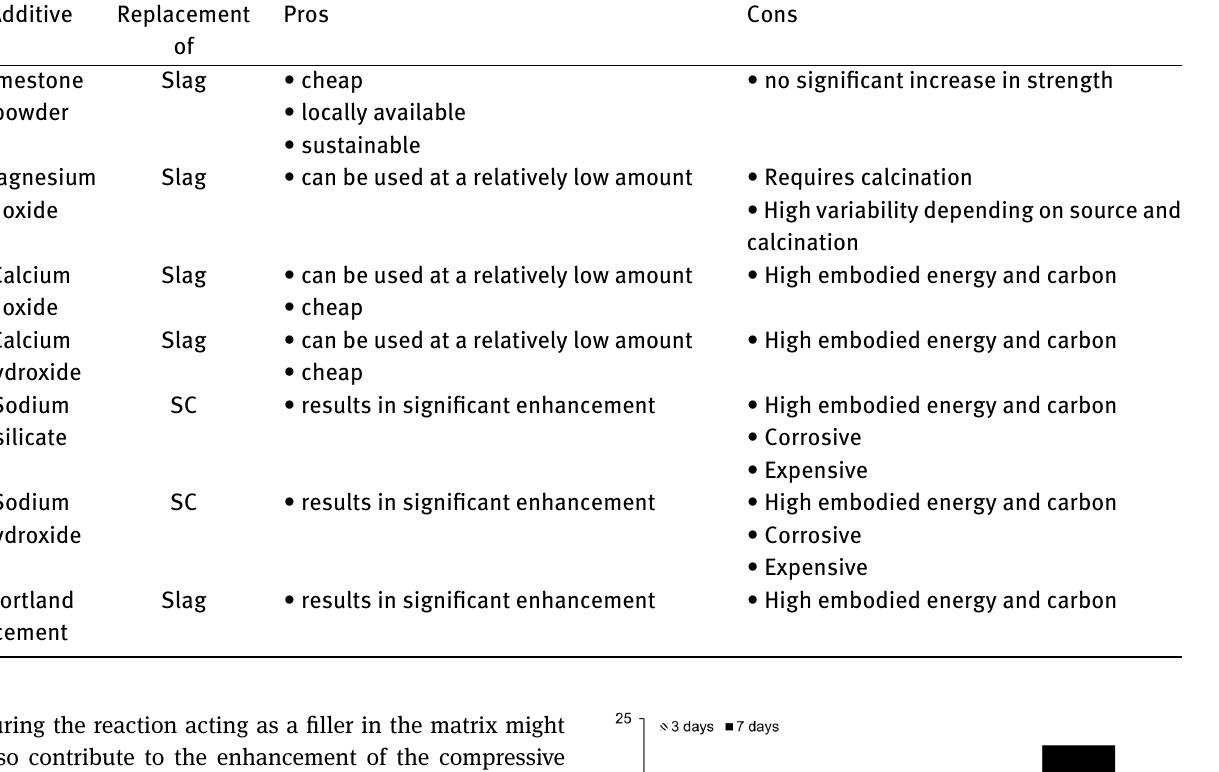
Table 1: Advantages and limitations of additives Additive Replacement Pros Cons of